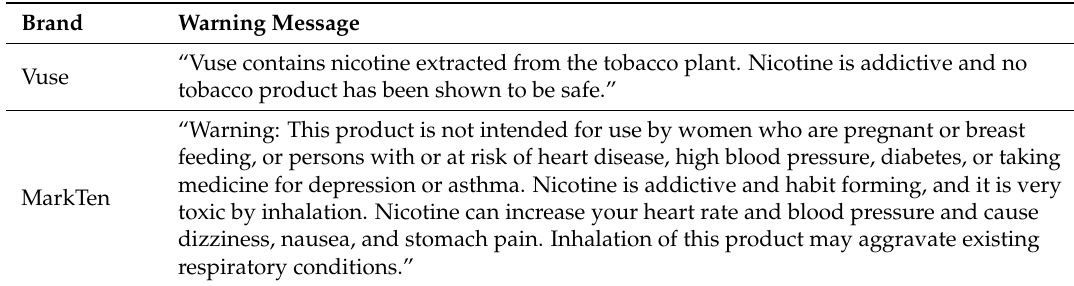
Table 3. Voluntary warning messages in presented Vuse and MarkTen e-cigarette print